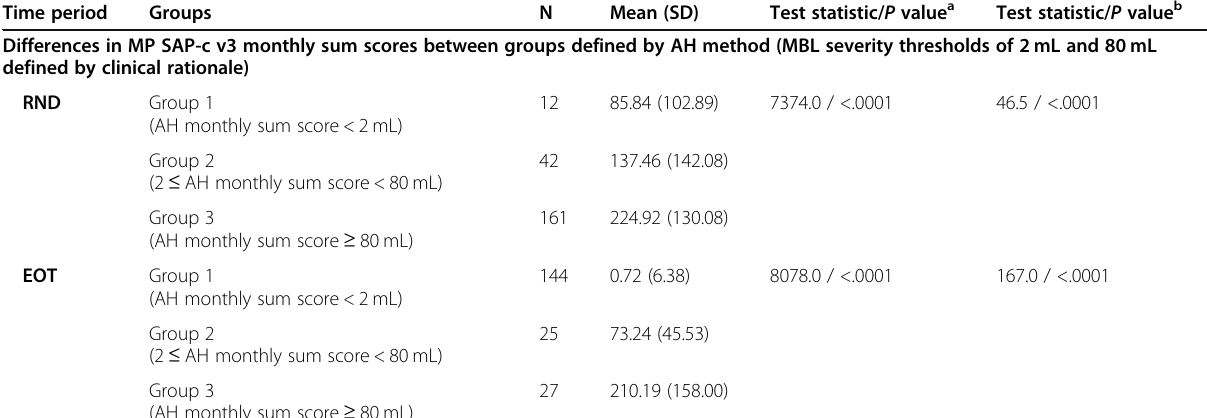
Table 4 Known groups validity analysis with MP and reference measures (monthly sum